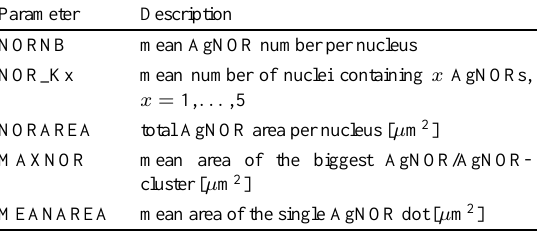
Selected AgNOR parameters measured by the program “norcolor”